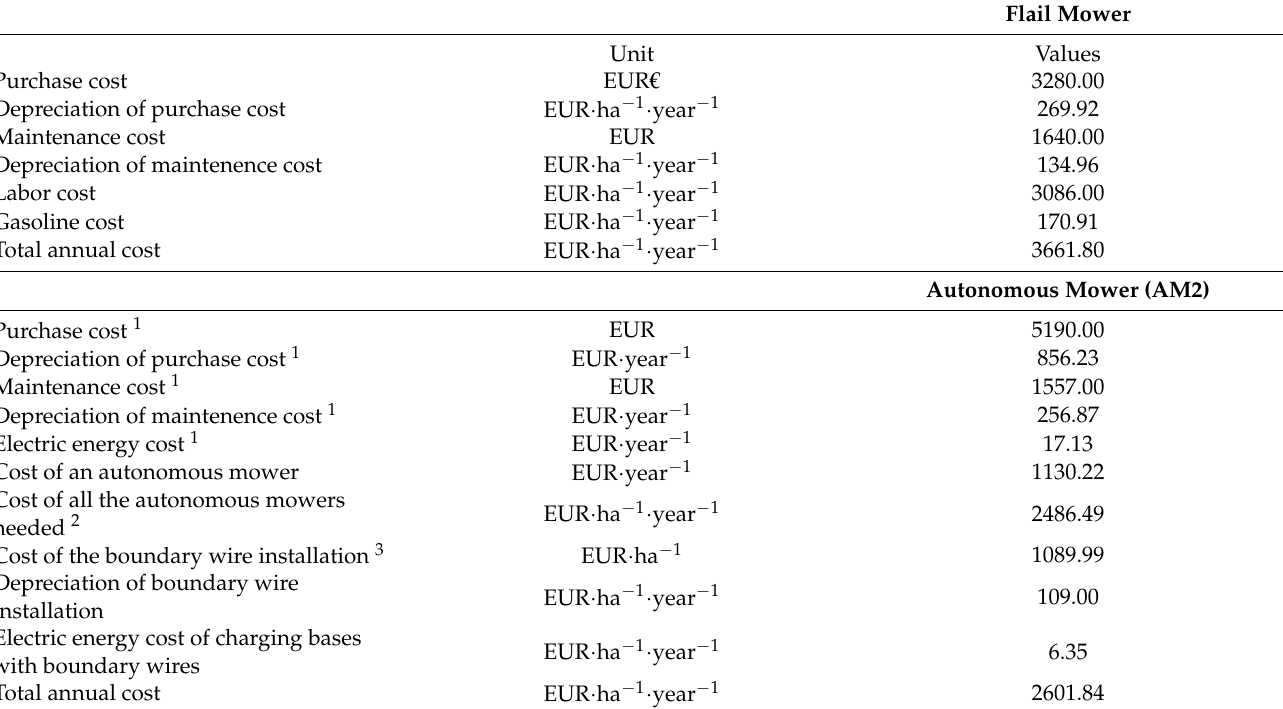
Table 8. Cost estimation of the two weed management